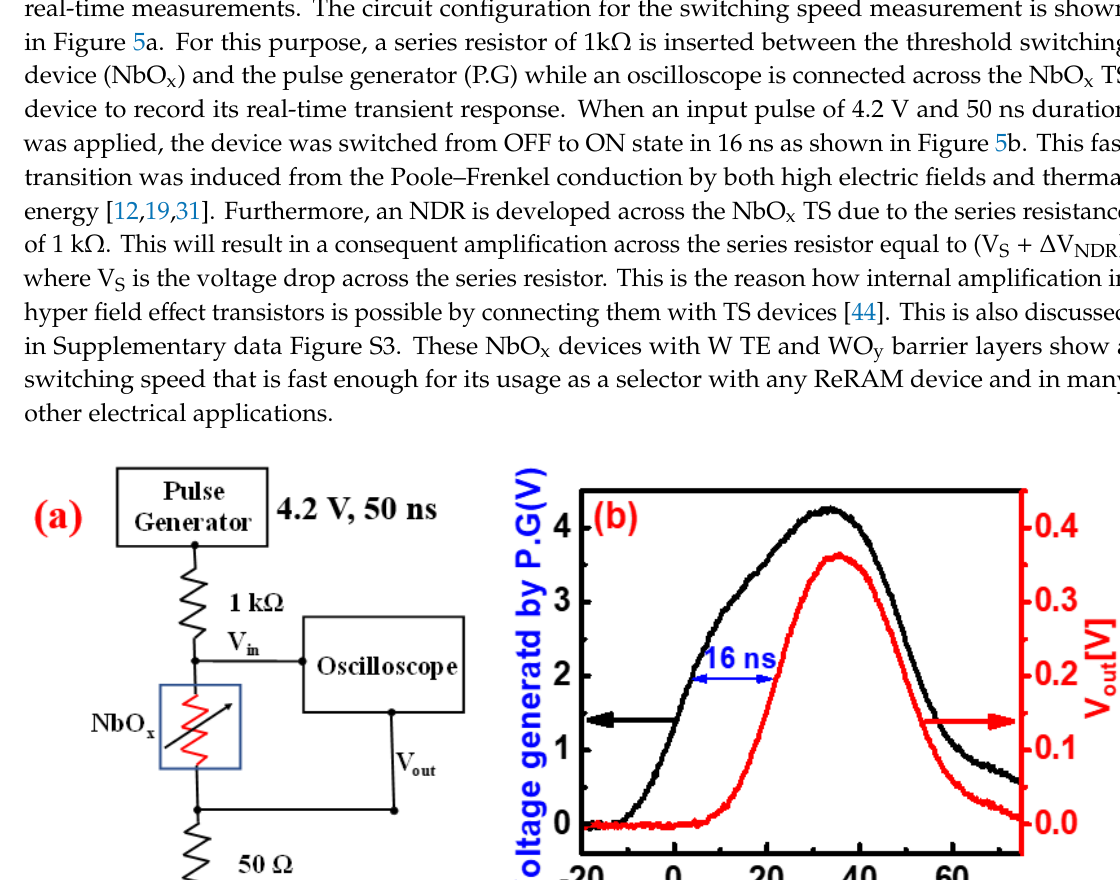
potentials ∆ G of the reaction equations; Figure S1: (a) Cross-sectional SEM image of NbOx / Pt devices, (b) AFM images of as-grown NbOx films with root mean square roughness (RMS) and the grain size (GS) value shown; Figure S2: Electroforming process of simple NbOx / Pt stack with 3 di ff erent top electrodes. (a) W, (b) Nb and (c) Au; Figure S3: (a) Measured current-voltage characteristics of W / WOy / NbOx / Pt devices under current controlled operation (inset shows the measurement circuit with series resistor), (b) Poole-Frenkel fit to the current